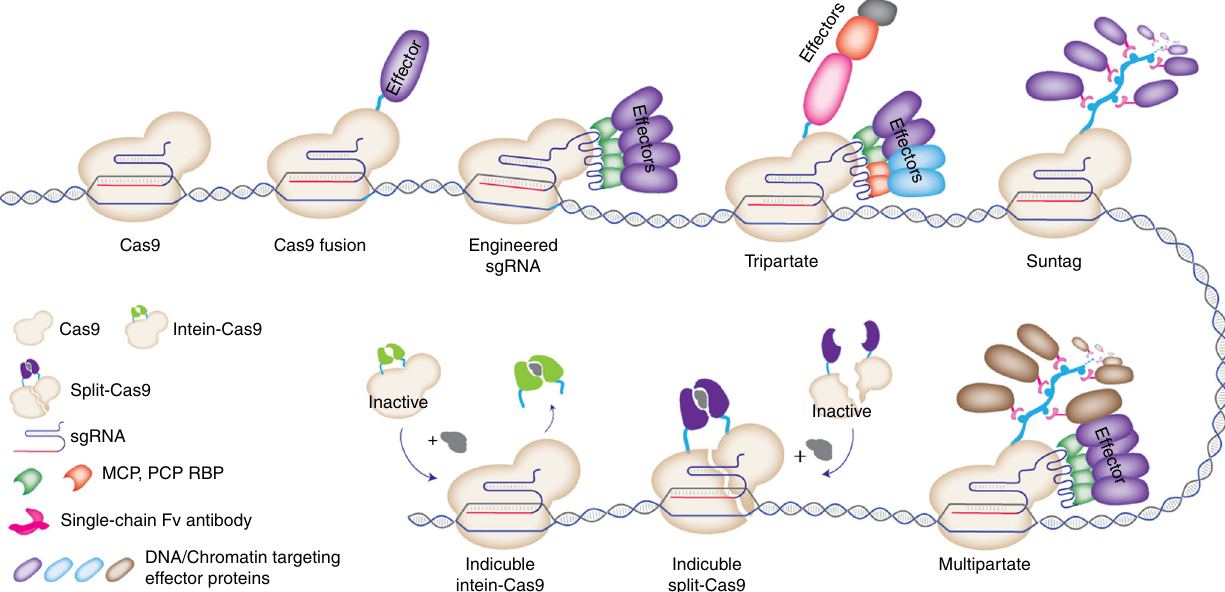
Fig. 4 Major strategies to recruit DNA- and chromatin-targeting and modifying enzymes via the CRISPR-Cas system. The schematics show various strategies of recruiting effector proteins to a target site using RNA guidable DNA binding capacity of Cas9-sgRNA complex. Effector proteins can be directly fused to active Cas9 or catalytically inactive dCas9 through a linker peptide. Additionally, the sgRNA scaffold can be engineered to contain multiple RNA aptamers that speci fi cally bind to a known RNA binding proteins (RBP) such as MCP or PCP. Effector proteins than can be guided to a target locus by fusing them to the RBPs. In the Tripartite strategy, multiple different effectors are being recruited through dCas9 as well as engineered sgRNA scaffold. The SunTag approach utilizes a repeating peptide array of protein scaffold to recruit multiple copies of an antibody-fused effector protein. Chemically inducible strategies enable temporal control over the activity of Cas9 or Cas9 fused effector proteins. In split Cas9, each halves of Cas9 protein can be induced to form functional complex. In the intein-Cas9 approach, the intein protein segment can be chemically induced to excise from Cas9 and result in its